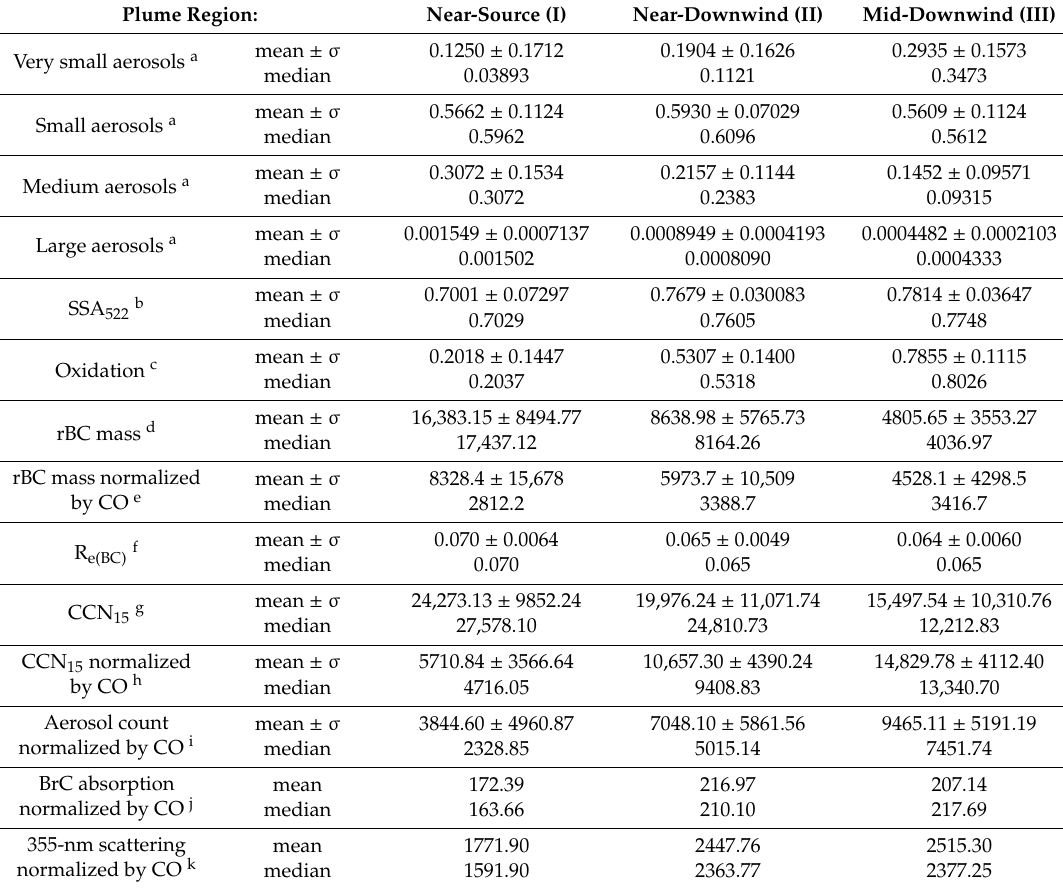
Table 4. Aircraft data: aerosol size, chemical, and physical properties for the Government Flats Complex Fire measured in